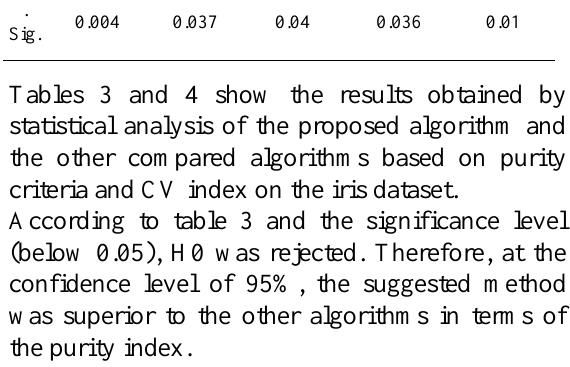
Table 4. Statistical analysis of algorithms based on CV criteria on iris dataset. K-means vs.